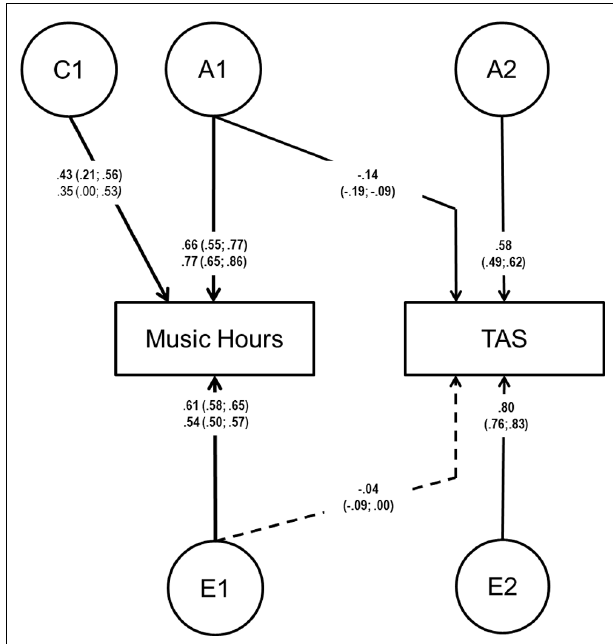
FIGURE 3 | Reduced sex-limitation model with separate pathways for males (bottom) and females (top) for music practice andTAS with the specific C factor onTAS and the C cross-path dropped. A = additive genetic; C = common/shared environmental; E = non-shared